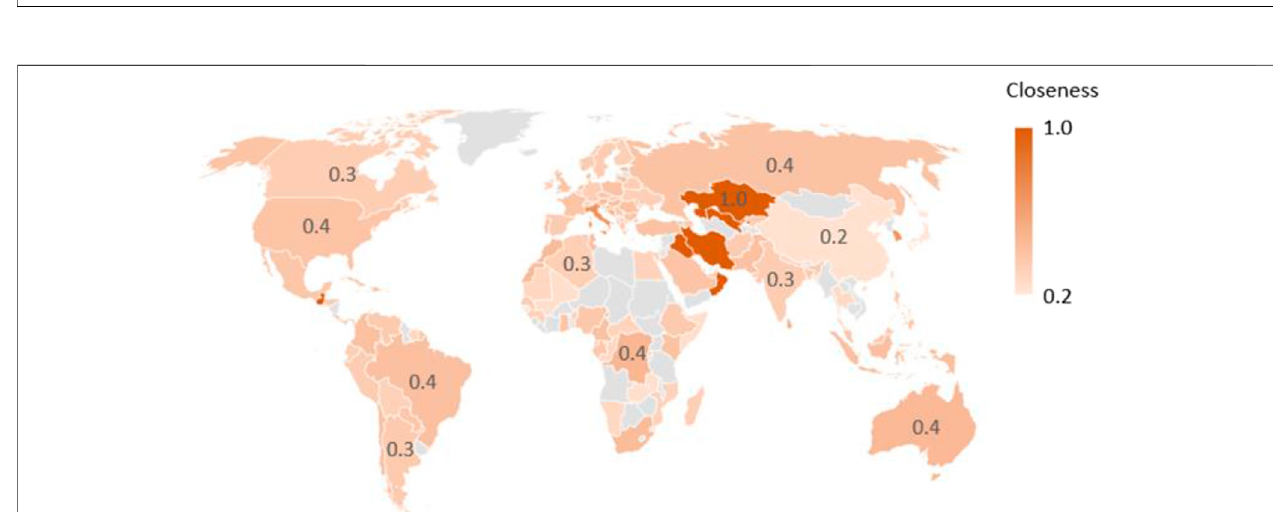
FIGURE 6 | The eigencentrality of the global COVID-19 pandemic network.